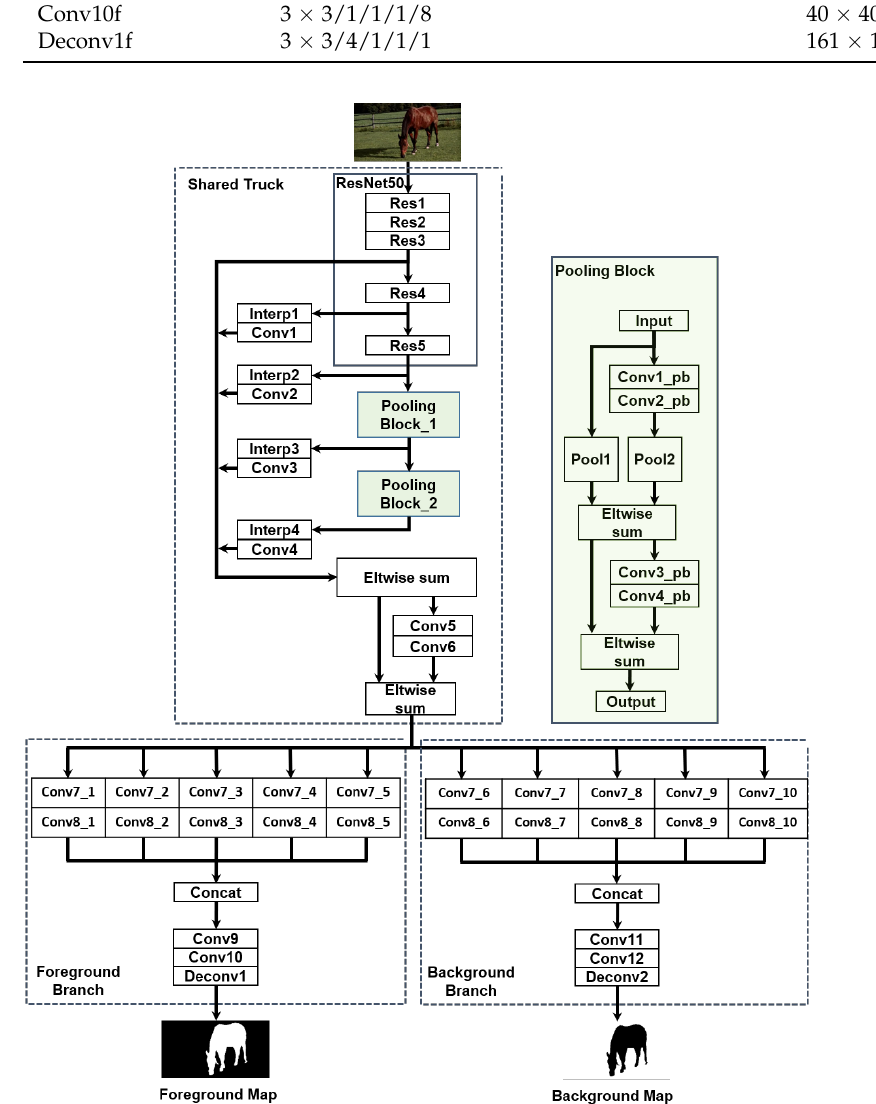
Figure 3. Architecture of the proposed CSNet. Note that layers Res1 and Res2/3/4/5 correspond to layers conv1 and conv2_x/3_x/4_x/5_x in [64], respectively. More details are shown in Table